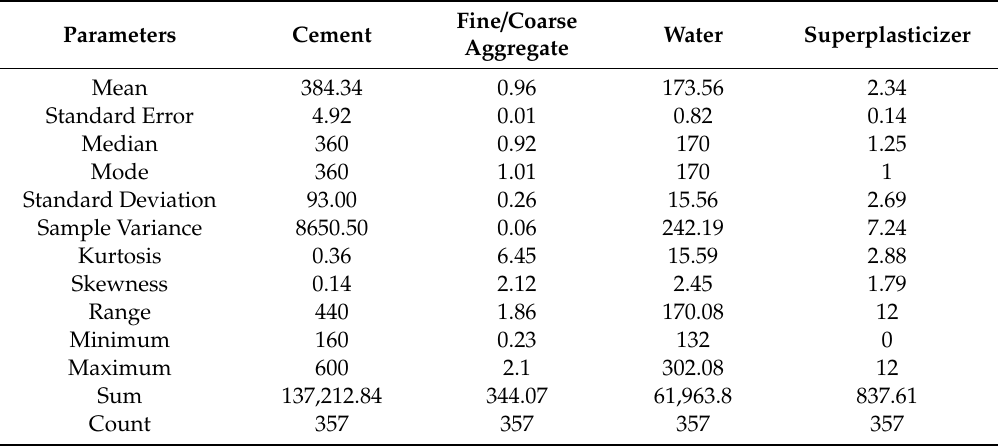
Table 2. Statistical description of all data points used in model (Kg / m 3 ).